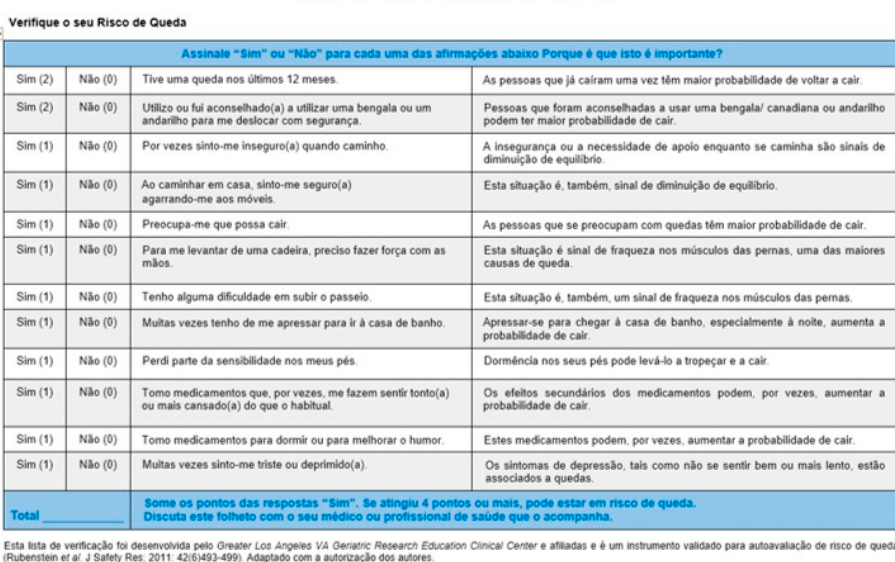
Figure 1. Final version of the Fall Risk Questionnaire—Versão Portuguesa (FRQ-VP) [11].